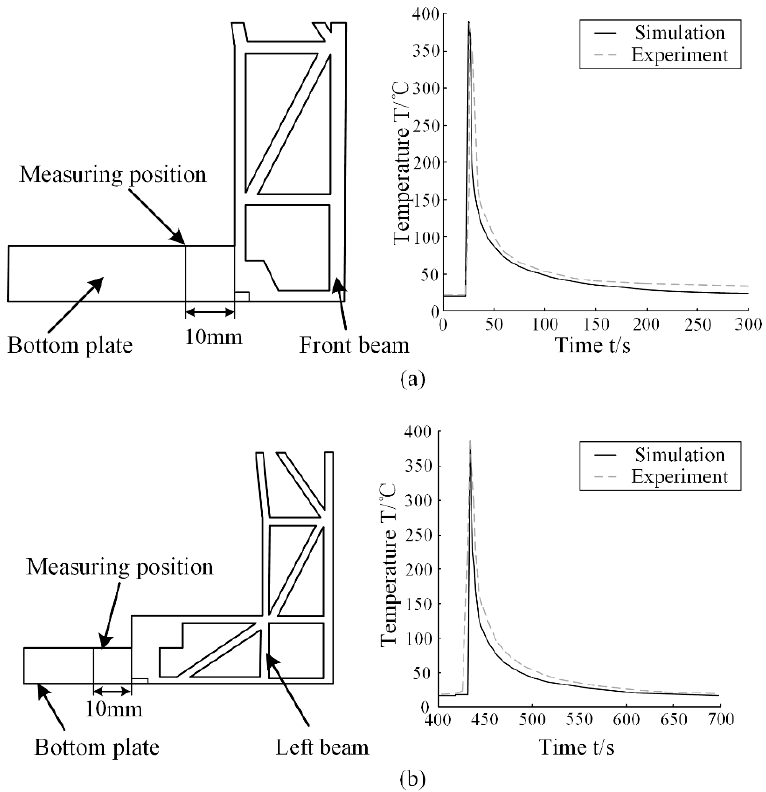
Figure 5. Thermal cycle curve of short-side weld and long-side weld of power battery enclosure: ( a ) the short side weld and the welding temperature curves of simulation and experiment; ( b ) the long side weld and the welding temperature curves of simulation and experiment.